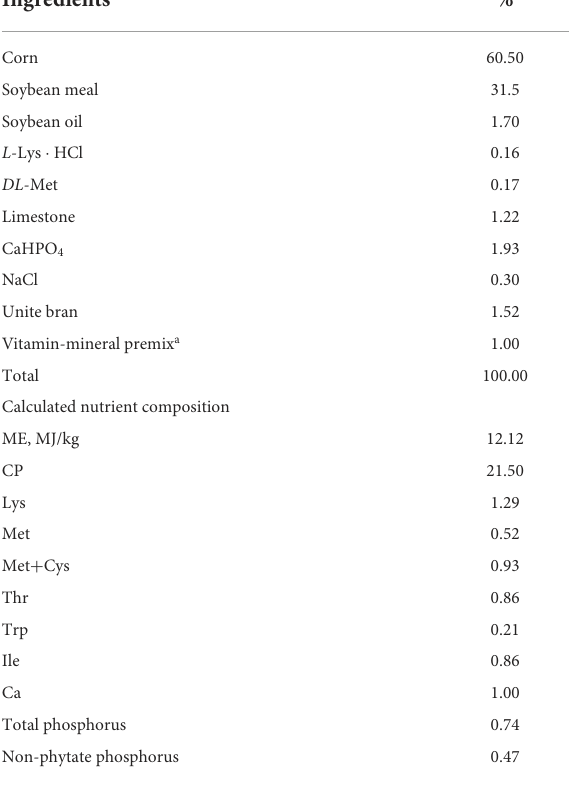
TABLE 1 Composition and nutrient levels of basal diets (as-fed basis)